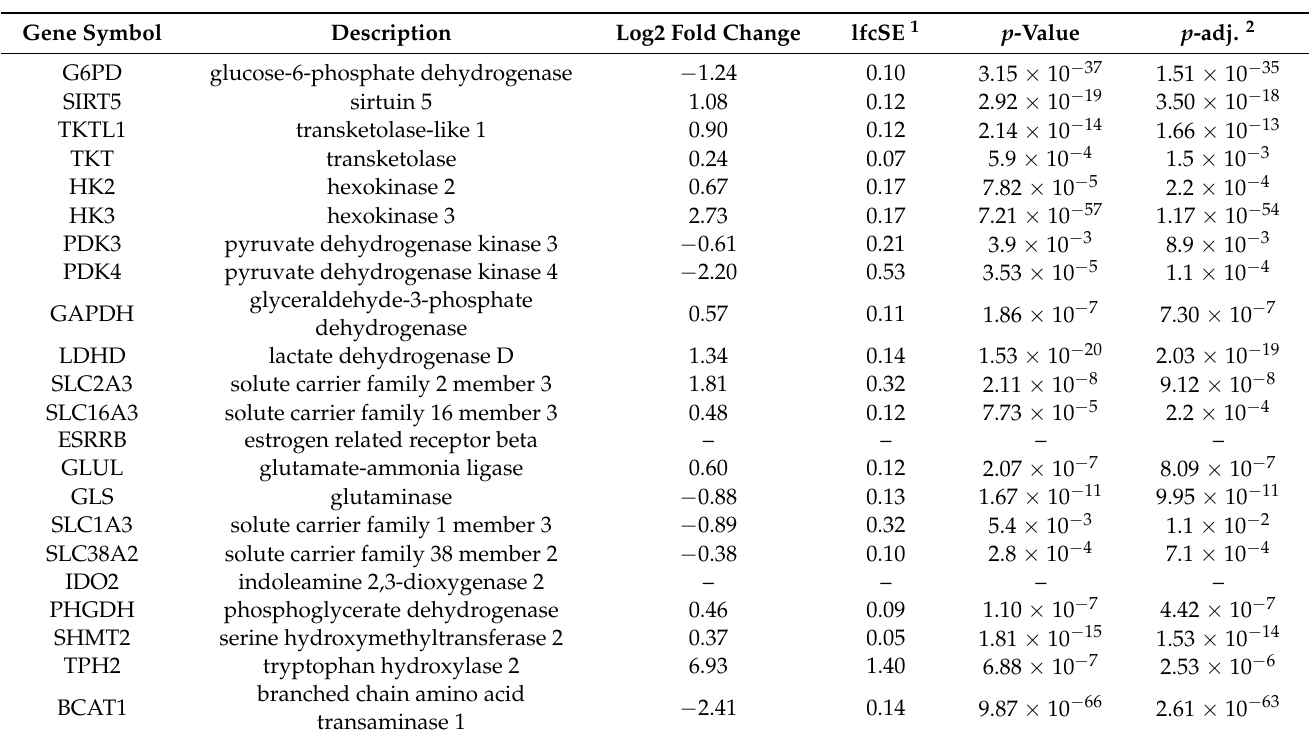
Table A2. Differential gene expression comparing THP1 KD cells in hypoxia (n = 3) versus normoxia (n = 3).